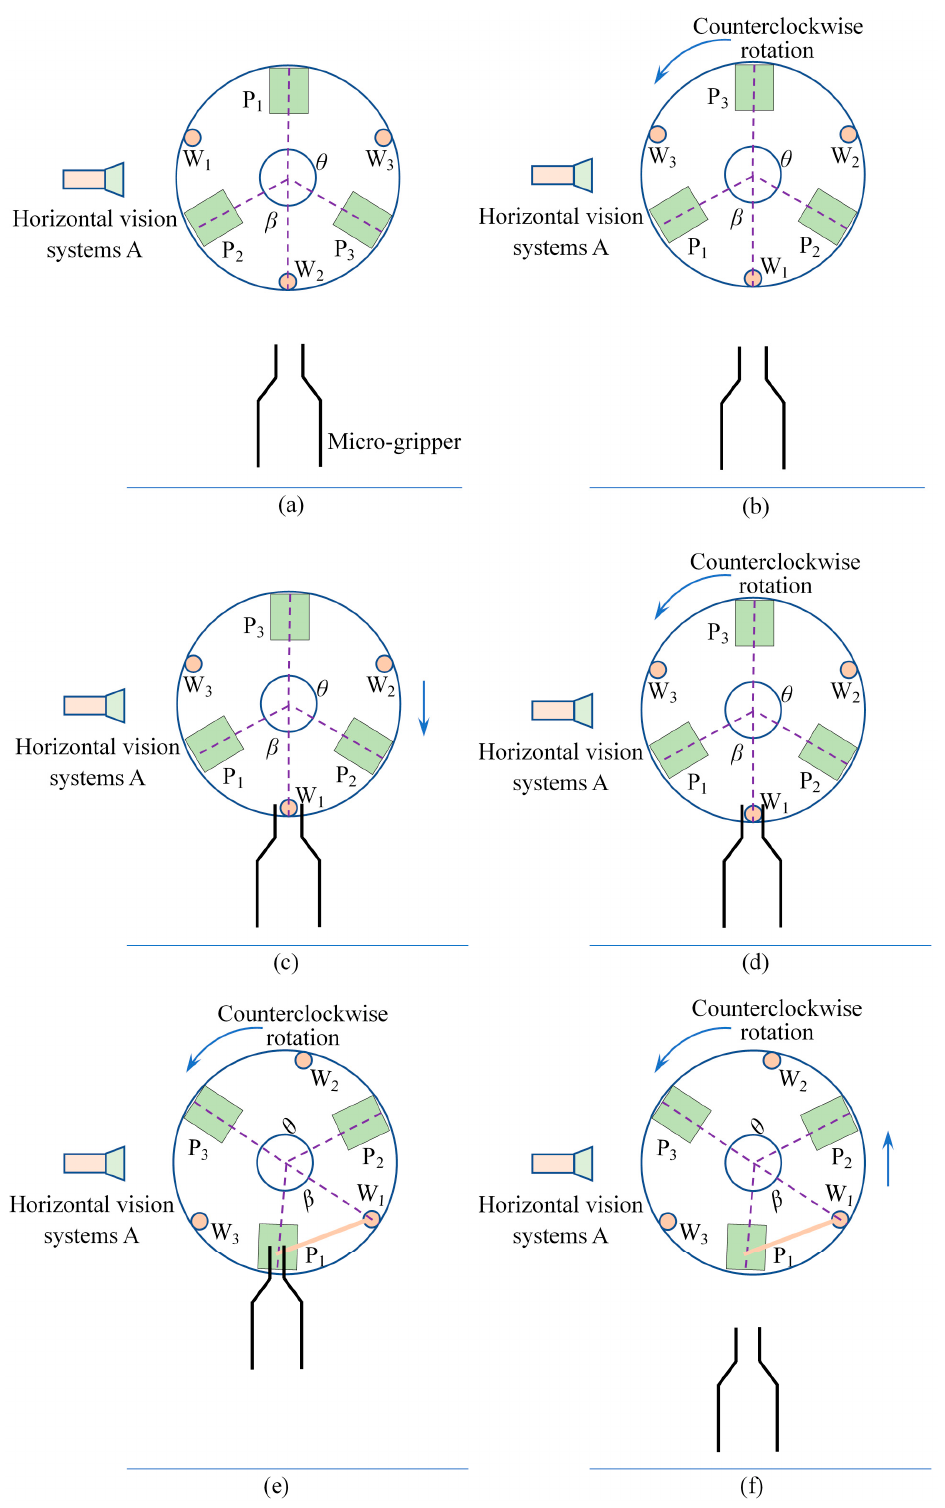
Figure 11. Electrode wire clamping traction strategy: ( a ) Electrode wire and pad positioning inspection; ( b ) Turn counterclockwise to the first wire position; ( c ) Electrode wire moved to clamp position; ( d ) Micro-gripper closure; ( e ) Electrode wire pulling to pad position; ( f ) Micro-gripper opens and returns to the initial position.